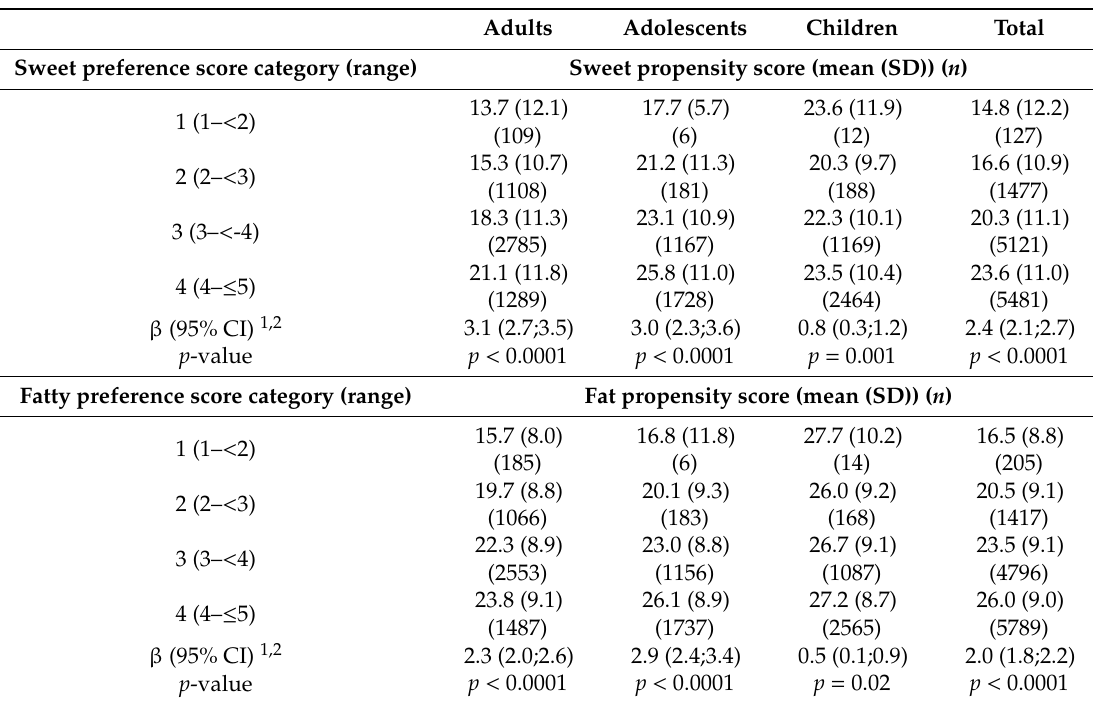
Table 3. Mean sweet and fatty food propensity scores within sweet and fatty taste preference score groups and β estimates for the association between sweet and fatty taste preference scores and sweet and fatty food propensity scores.